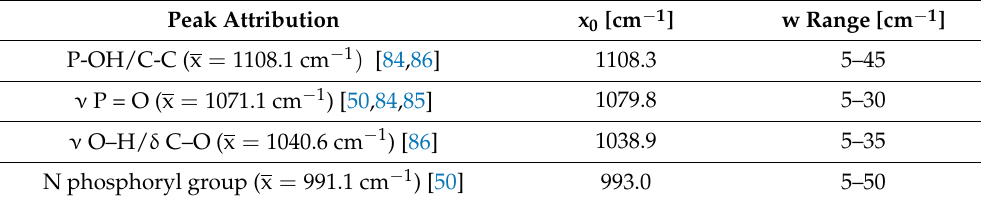
Table 1. Restriction of EPS production peak parameters and expected peak attributions in the spectral region from 1150–950 cm − 1 of Lentilactobacillus parabuchneri DSMZ 5987 + MRS biofilm inhibition were used to evaluate the cumulative impulse fit of polysaccharides by the influence of chitosan and its TMC